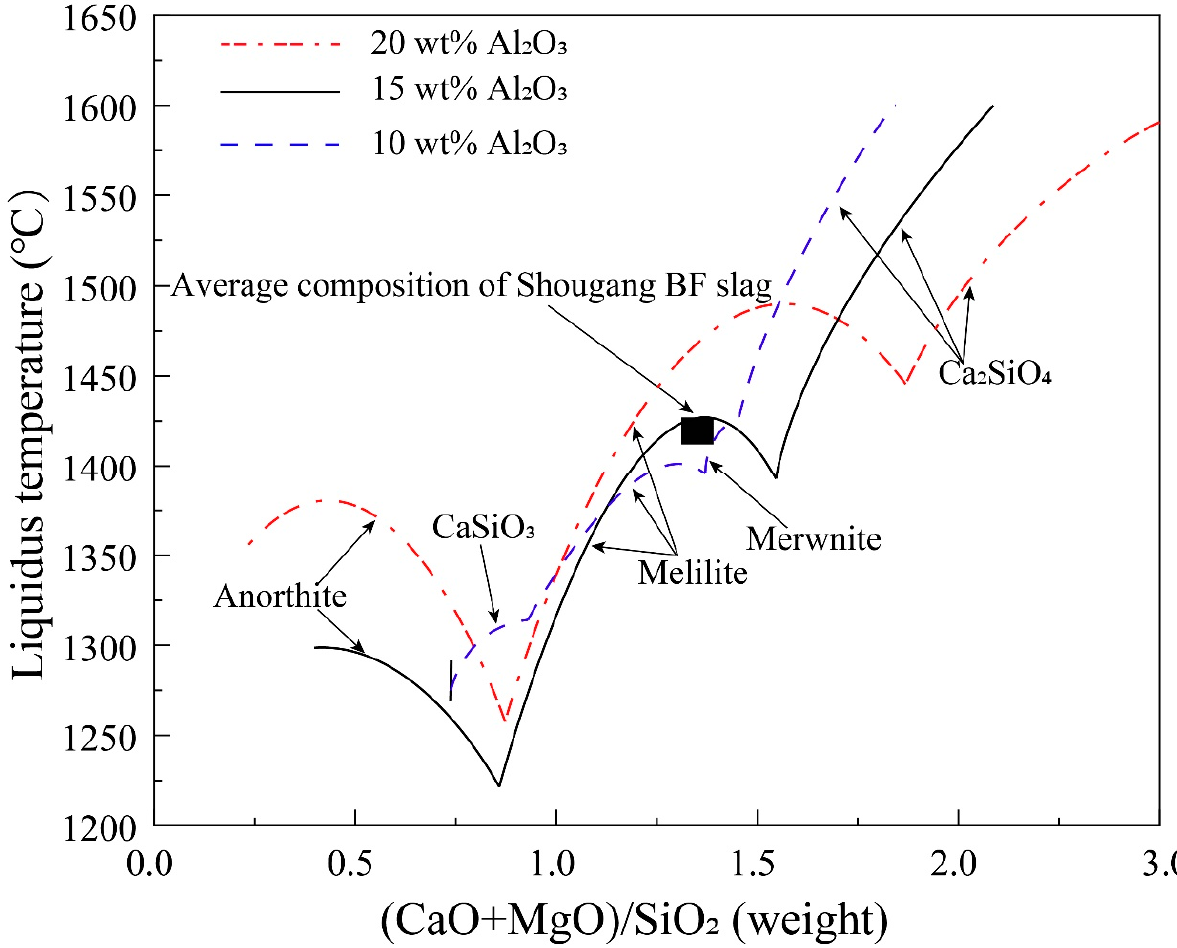
Figure 18. Liquidus temperature as a function of quaternary basicity at fixed MgO/CaO and Al 2 O 3 /SiO 2 ratios